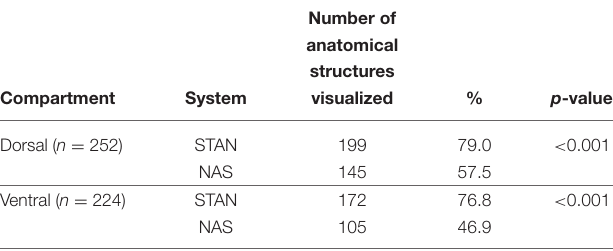
TABLE 2 | The total number of anatomical structures visualized compared by arthroscope system and joint compartment.